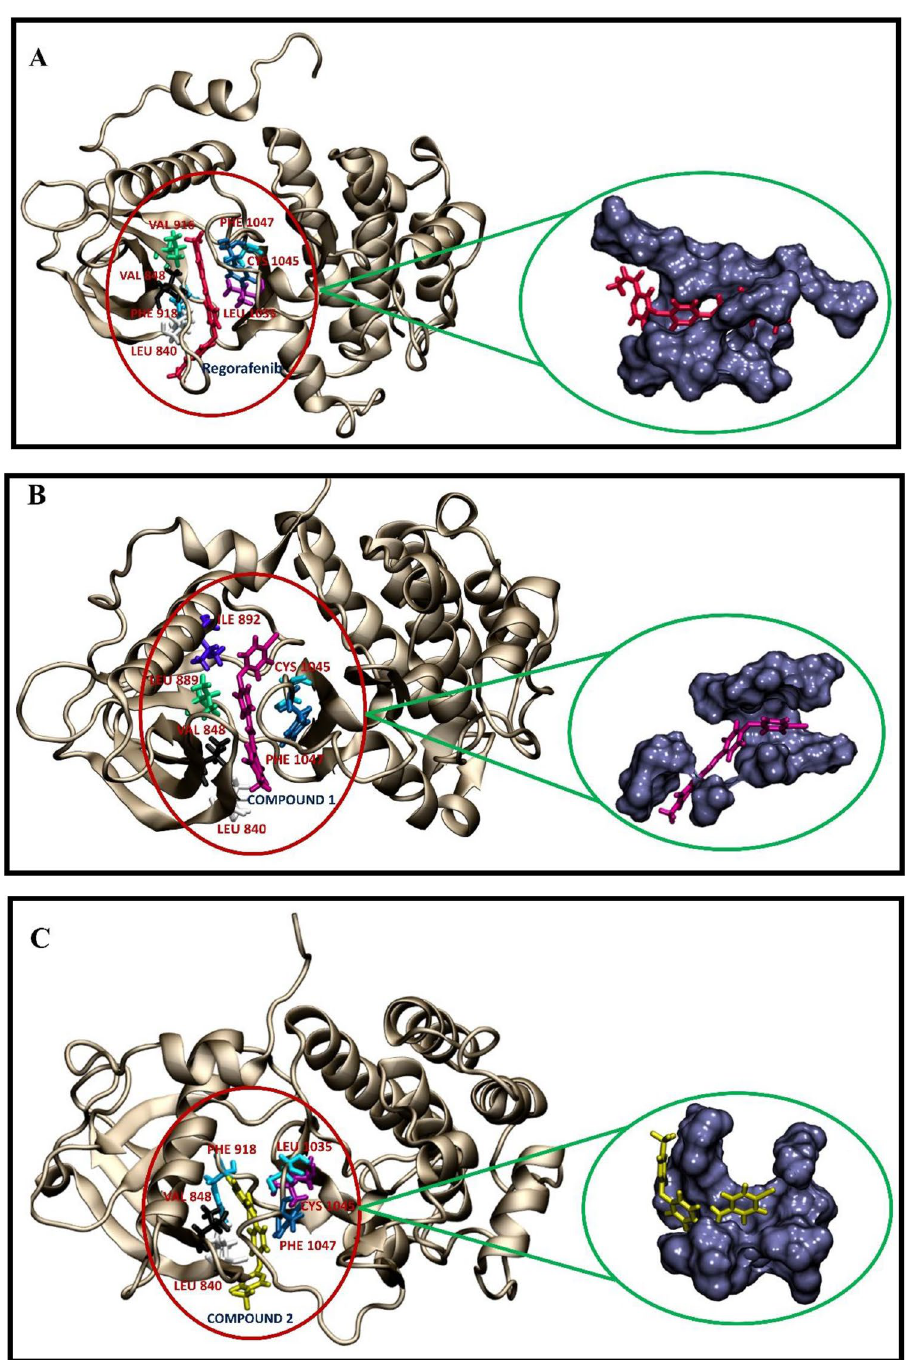
Figure 8. Geometries of residues that contributed highly to the binding free energy during the interaction between ligands and VEGFR2 crystal structure. The VEGFR2 structure was obtained from PDB ID: 4ASE. The binding pockets within 3 Å surrounding the ligands were highlighted using the surface representation. The figures are created by using visual molecular dynamics (VMD) v.1.9.2, https:// www. ks. uiuc.